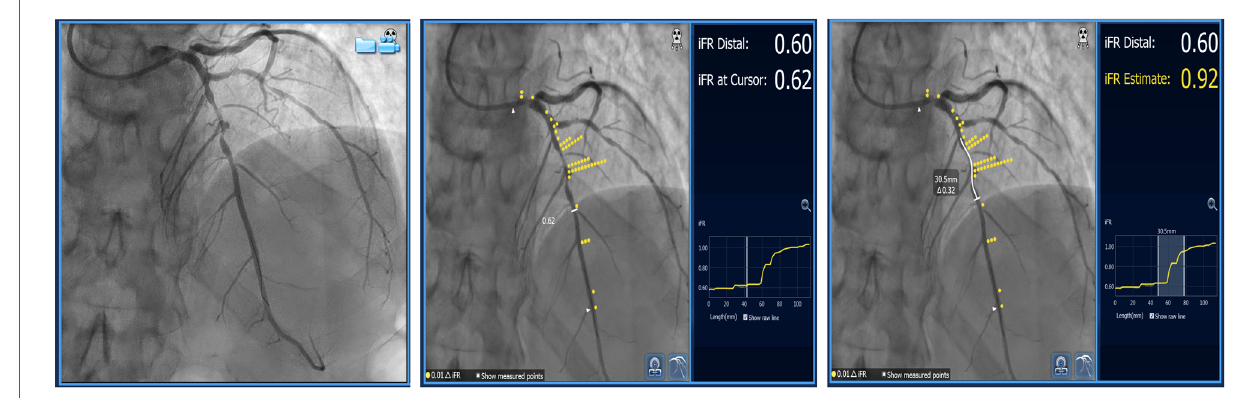
FIGURE 4 Serial lesion assessment using iFR and co-registration with “ Sync Vision ” software (Philips Healthcare, The Netherlands). The images show mid-LAD serial lesions assessed by iFR, and each yellow dot represents a 0.01 value in iFR Reading. The white-butted line in the right image demonstrates the potential effect of stent implantation on iFR value change ( Δ